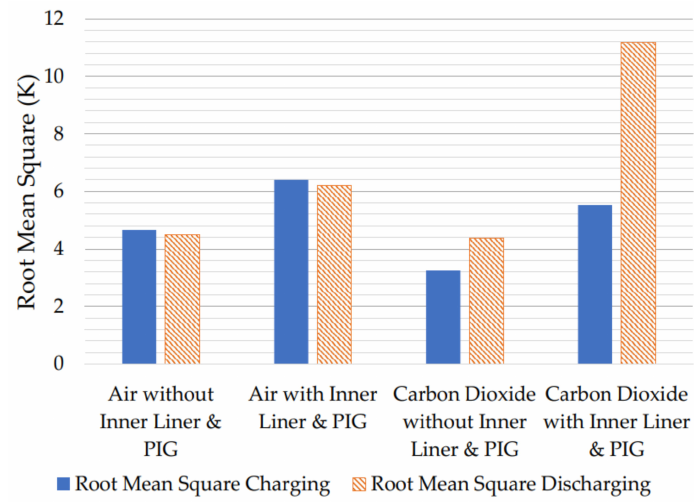
Figure 9. Root mean square for charging and discharging stages for the systems with/without inner liner and pipeline inspection gauge, having air and CO 2 as the compressible gas while the system operates at 250 kW for both charging/discharging stages and 4 h for both hold stages.